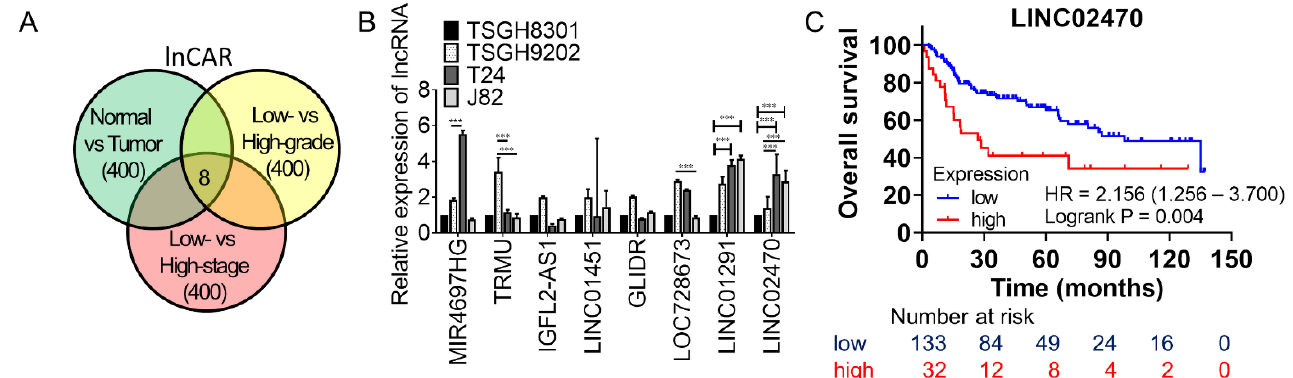
Figure 1. Eight candidate lncRNAs in the lnCAR database were screened out, with subsequent evaluation of LINC02470. ( A ) Eight candidate lncRNAs were obtained from the lnCAR database by intersection of higher expression in bladder cancer than normal specimens, higher expression in high-grade than low-grade specimens, and higher expression in high-stage than low-stage specimens. ( B ) Comparison of MIR4697HG, TRMU, IGFL2-AS1, LINC01451, GLIDR, LOC728673, LINC01291, and LINC02740 expression among different bladder cancer cells via qRT–PCR. (*** p < 0.001, Student’s t -test) ( C ) Higher LINC2470 expression was associated with worse overall survival of bladder cancer patients in the GSE13507 dataset.